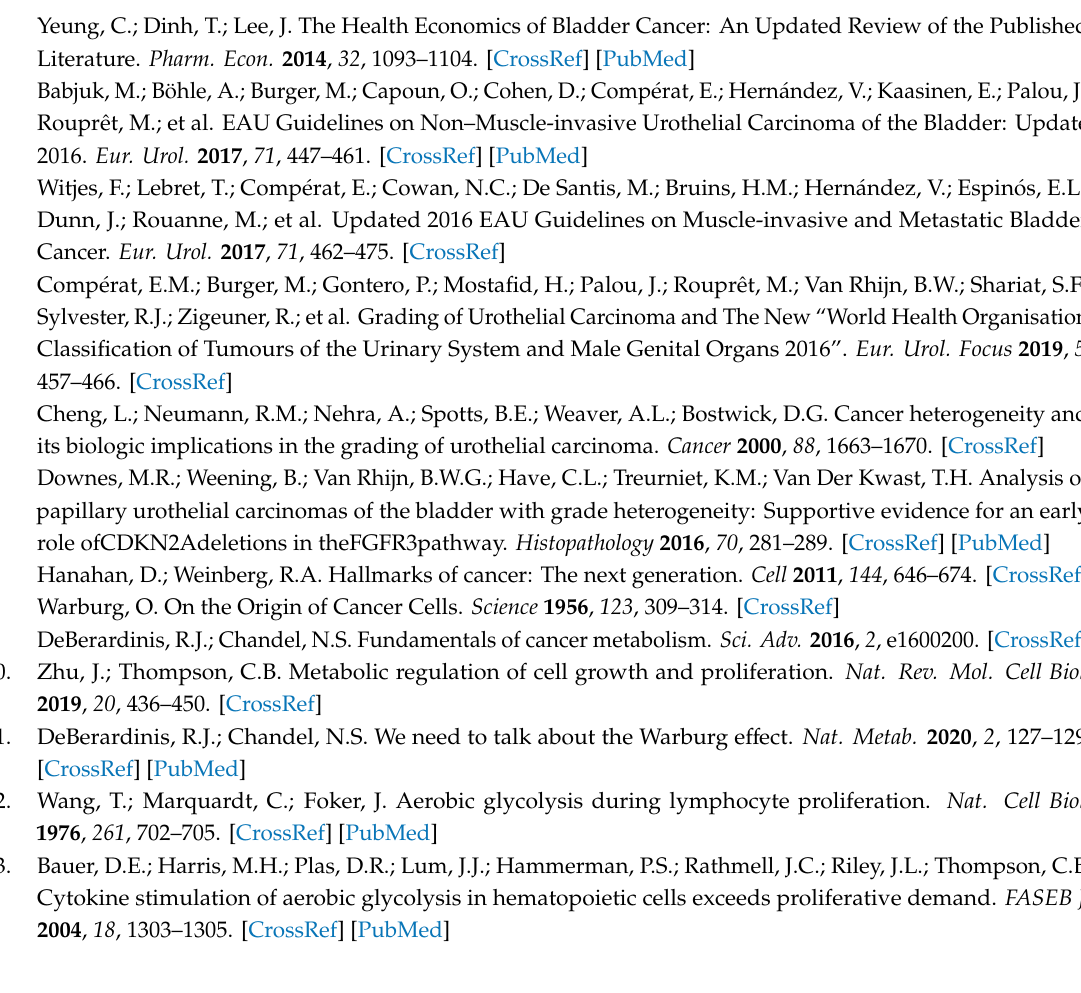
Figure S1: Quantitative imaging by Operetta CLS ™ high-content analysis and the Harmony software. Figure S2: RT112 and 5637 cells spheroids formation capacity. Figure S3: Figure S3 Oligomycin and FCCP optimization for the measurement of glycolytic and respiratory bioenergetics, and mRNA levels of selected glycolytic enzymes di ff erentially expressed in RT112 and 5637 cells. Figure S4: Figure S4. Lipid content, lipid peroxidation and redox homeostasis in RT112 and 5637 cells. Figure S5: Spheroid formation capacity of RT112 and 5637 cells under pharmacological treatment; Video S1: RT112 and 5637 cells migration